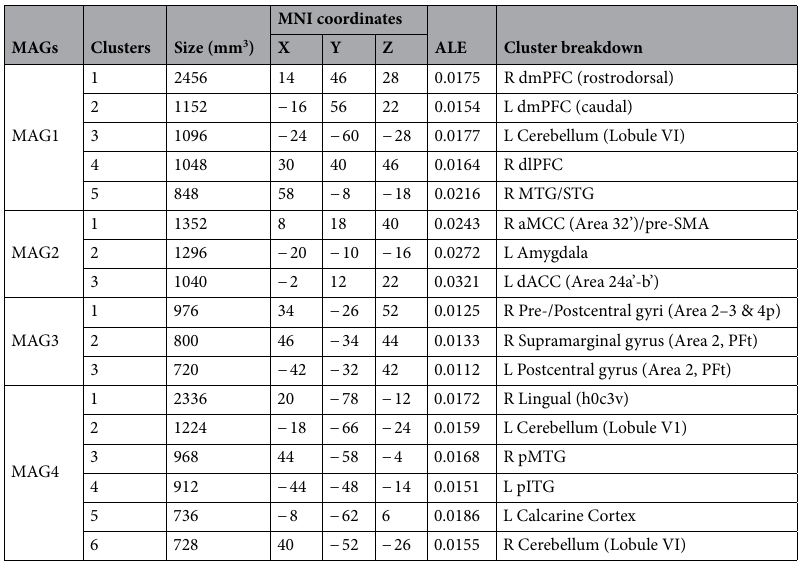
Table 1. ALE meta-analysis results of each significant groups of experiments. MAG meta-analytical grouping, PFC prefrontal cortex, dmPFC dorsomedial PFC, dlPFC dorsolateral PFC, MTG middle temporal gyrus, STG superior temporal gyrus, aMCC anterior midcingulate cortex, pre‑SMA pre-supplementary motor area, dACC dorsal anterior cingulate cortex, IPL Inferior Parietal Lobule, SPL superior parietal lobule, pMTG posterior MTG, pITG posterior